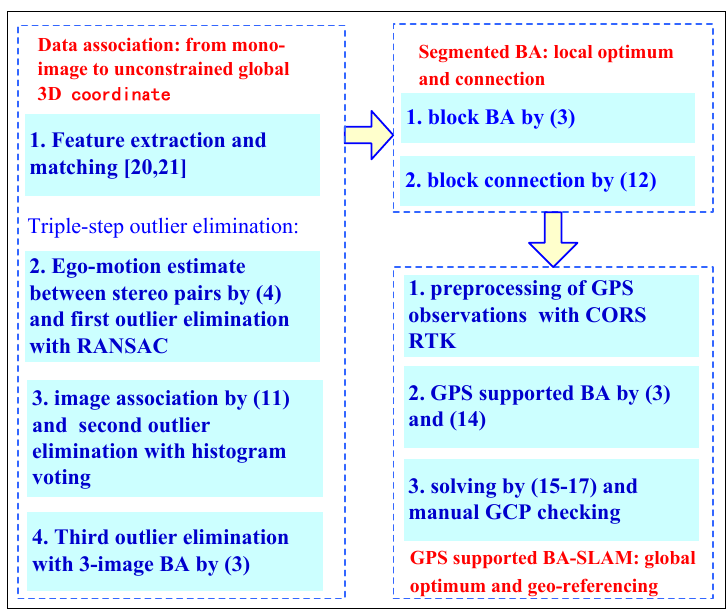
Figure 3. The main workflow of GPS-supported